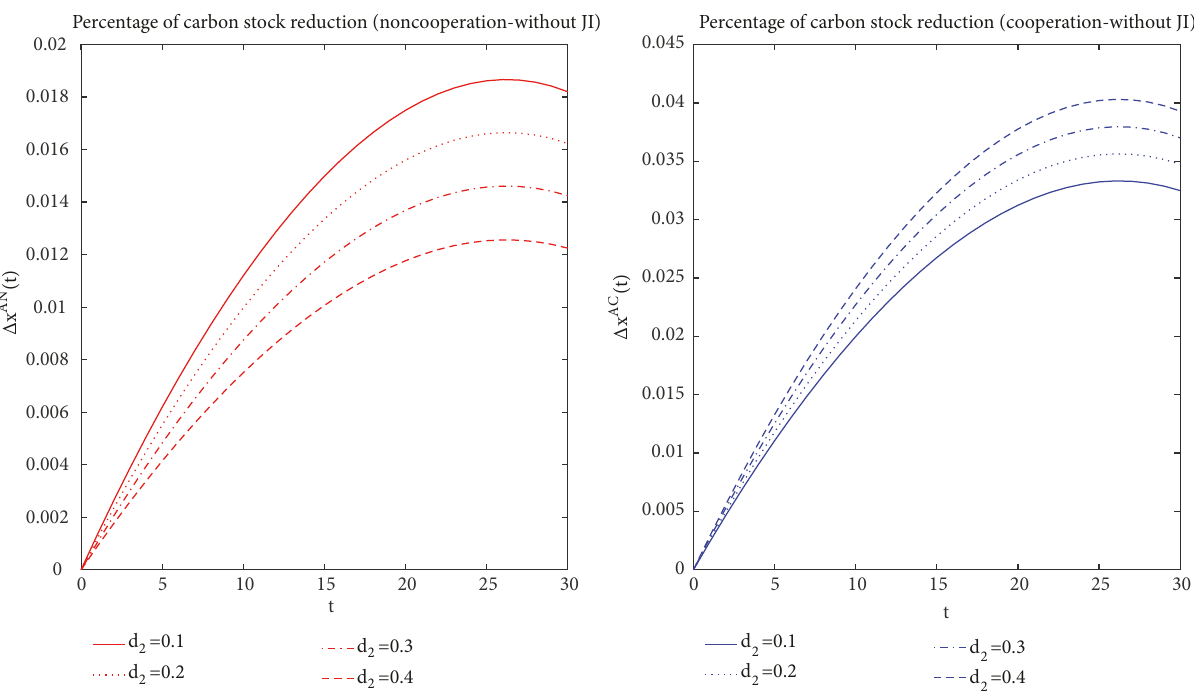
Figure 5: The behavior of percentage of carbon stock reduction as 𝑑 2